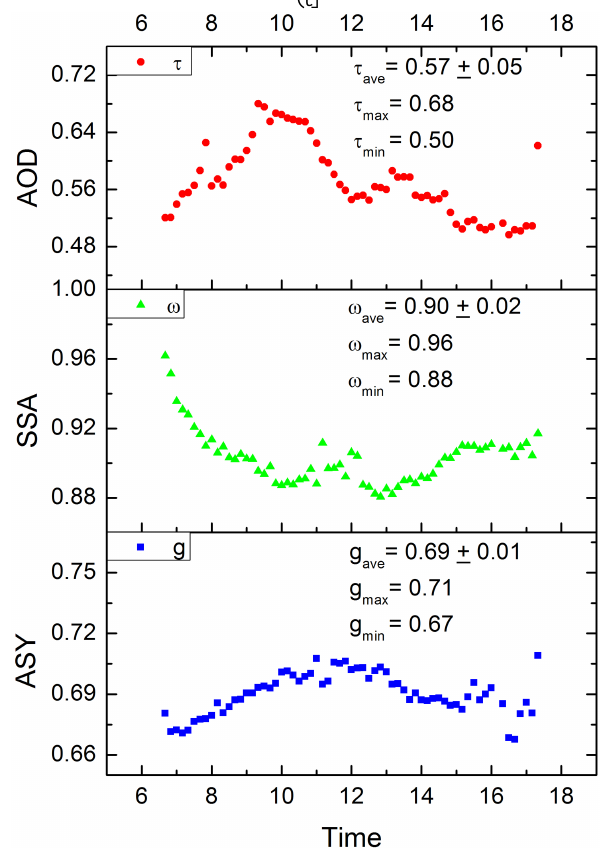
Figure 1. Daily variations of retrieved 500nm AOD (red), SSA (green) and ASY (blue) on 14 April 2013. This represents a typi- cal light polluted case (mean AOD of 0.57) with moderate diurnal changes of